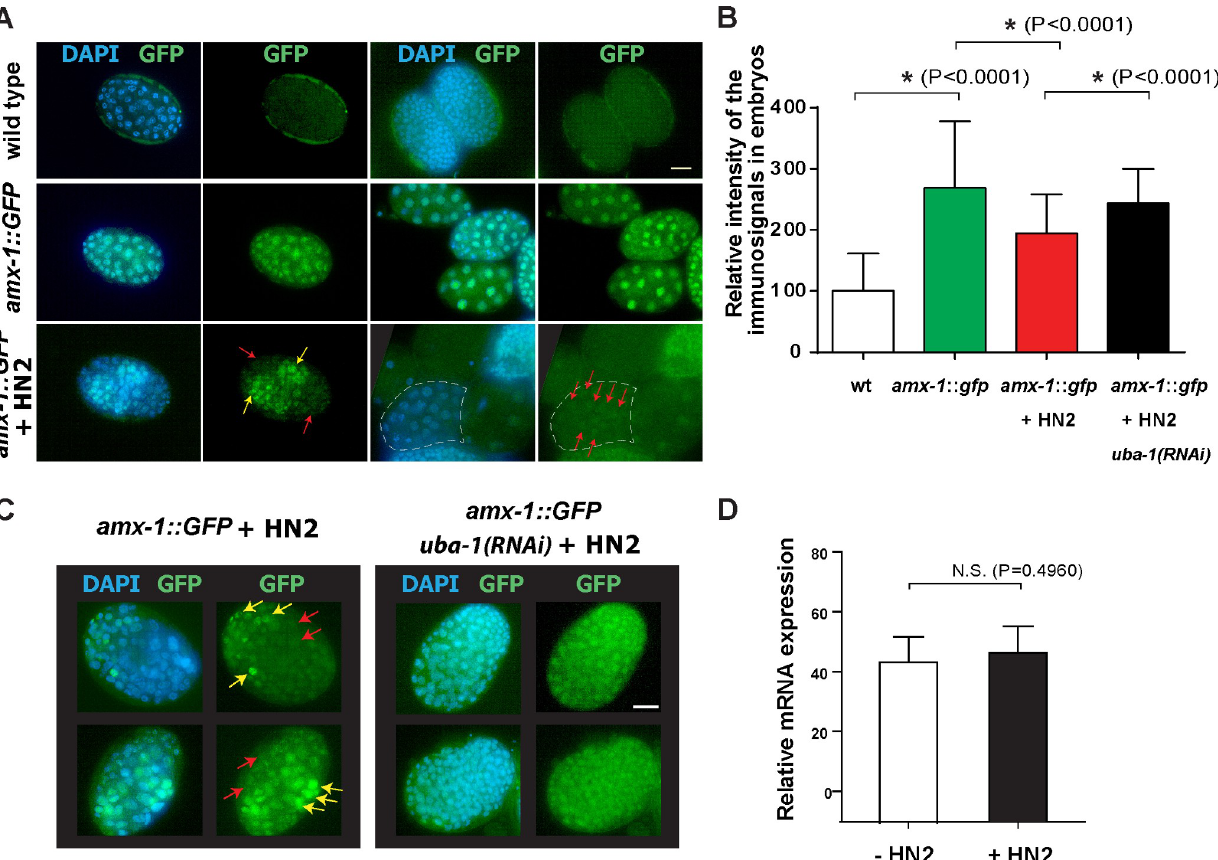
Fig 6. Interstrand crosslink DNA damage leads to ubiquitination-dependent AMX-1 relocalization. (A) Nitrogen mustard (HN2) exposure induces relocalization of AMX-1::GFP signals. Arrows indicate embryo cells containing no/weak (red) or stronger (yellow) signals. Bar,10 μ m. (B) Quantitation of relative intensity of the AMX-1::GFP signal in embryos from the indicated genotypes. Asterisks indicate statistical significance. 66–250 embryos from 6–8 worms were analyzed. Error bars represent standard deviations. (C) Depletion by RNAi of the E1 ubiquitin-activating enzyme UBA-1, suppresses the uneven/mosaic signals exhibited in amx-1 ::GFP transgenic animals. AMX-1::GFP signal intensity from embryos are quantitated in panel B. P = 0.1084 from amx-1 :: GFP + HN2. (D) mRNA expression level of amx-1 is not altered after HN2 treatment. P = 0.4960. Error bars represent standard deviations.